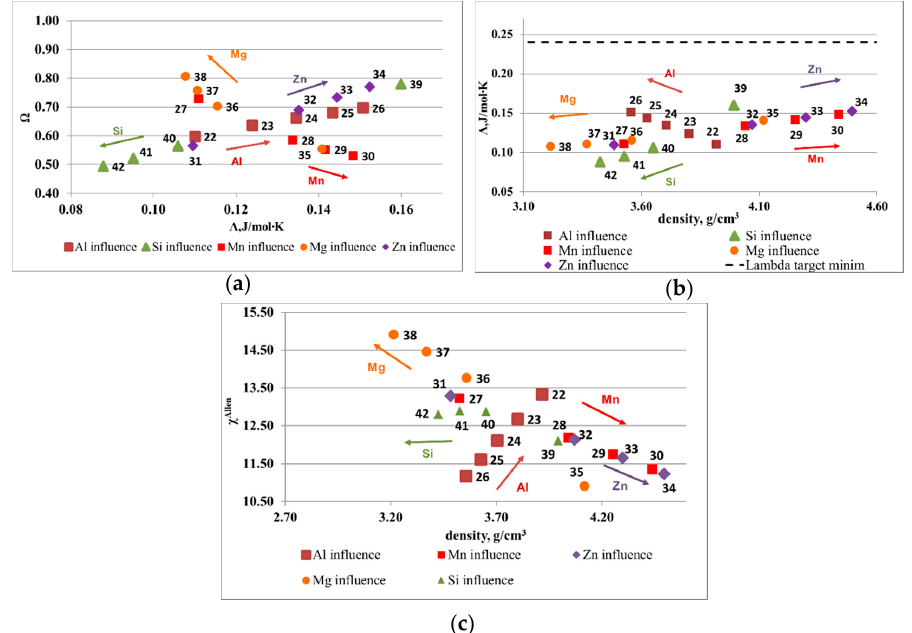
Figure 2. Elemental influence over the criteria values for Al-Mn-Zn-Mg-Si system: ( a ) Λ versus Ω , ( b ) Λ versus density, and ( c ) ∆χ Allen versus density.